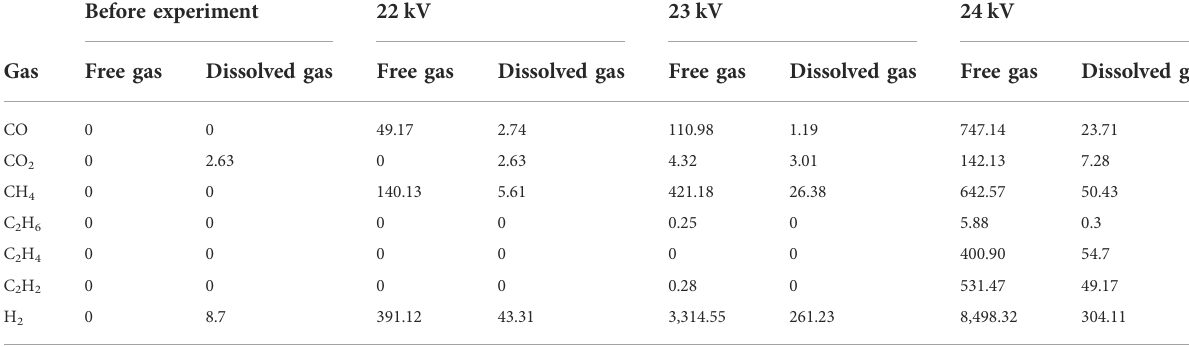
TABLE 2 Oil gap discharge defect model under different severity of oil surface gas and dissolved gas in oil (unit: μ L / L ). Before